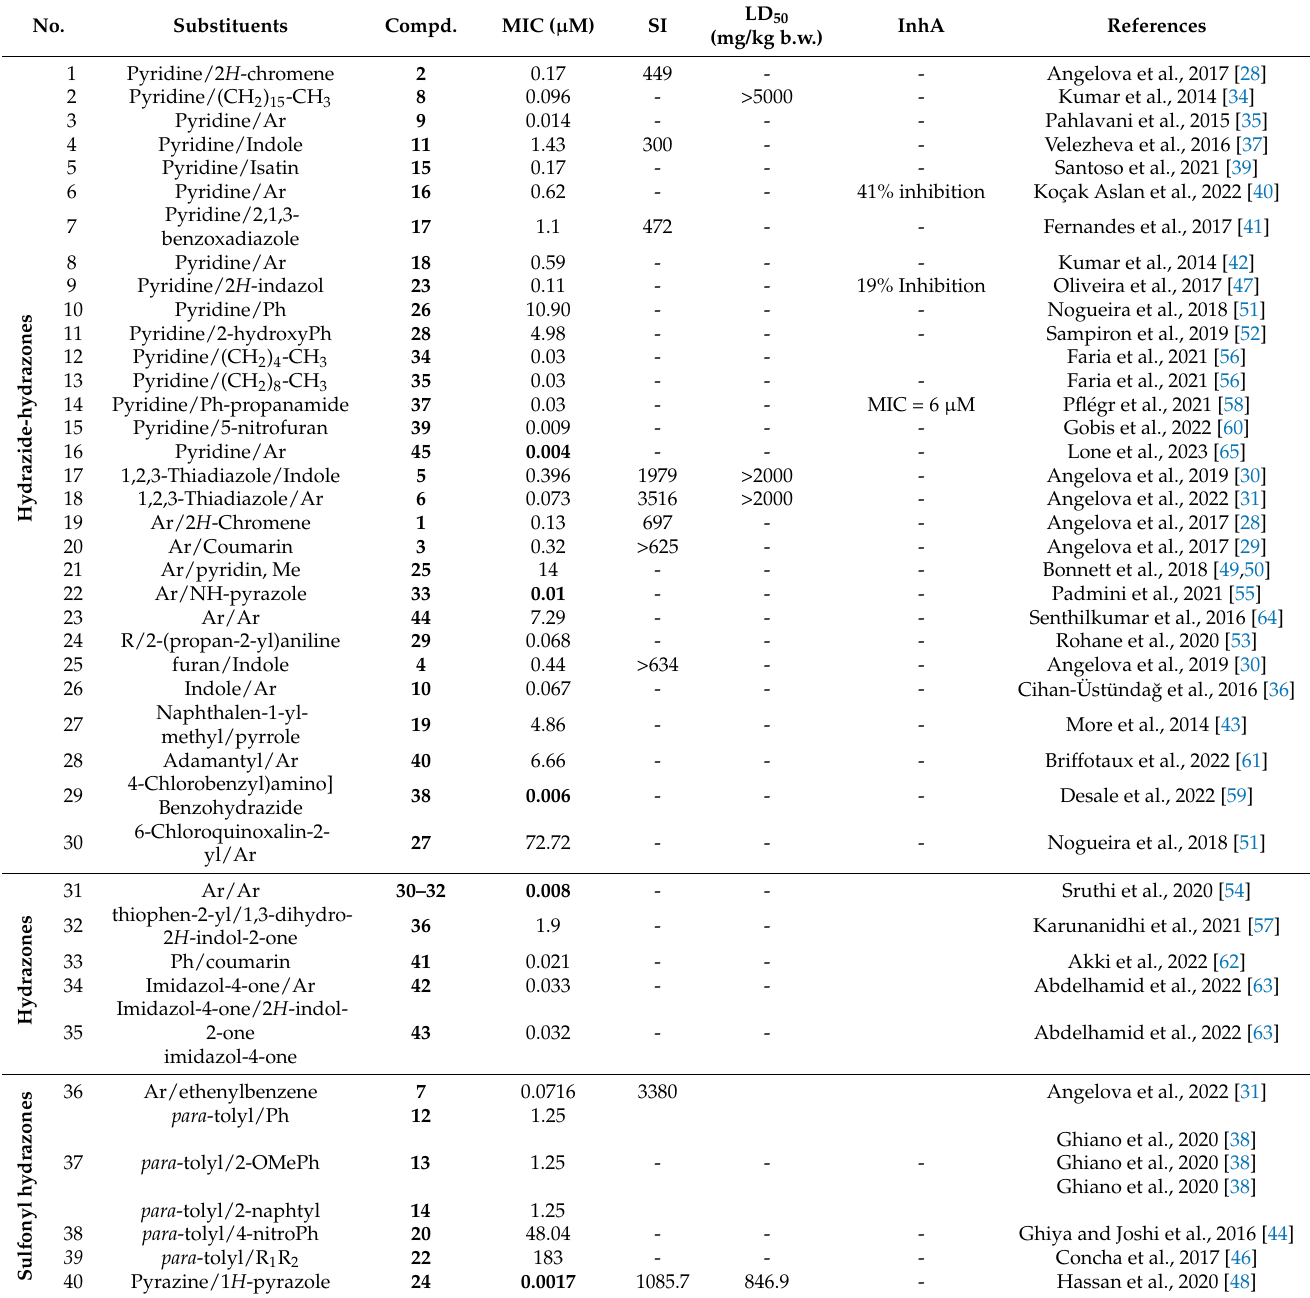
Table 1. Summary of anti-tubercular activity of hydrazone, hydrazide-hydrazone and sulfonyl– hydrazine derivatives (last 10